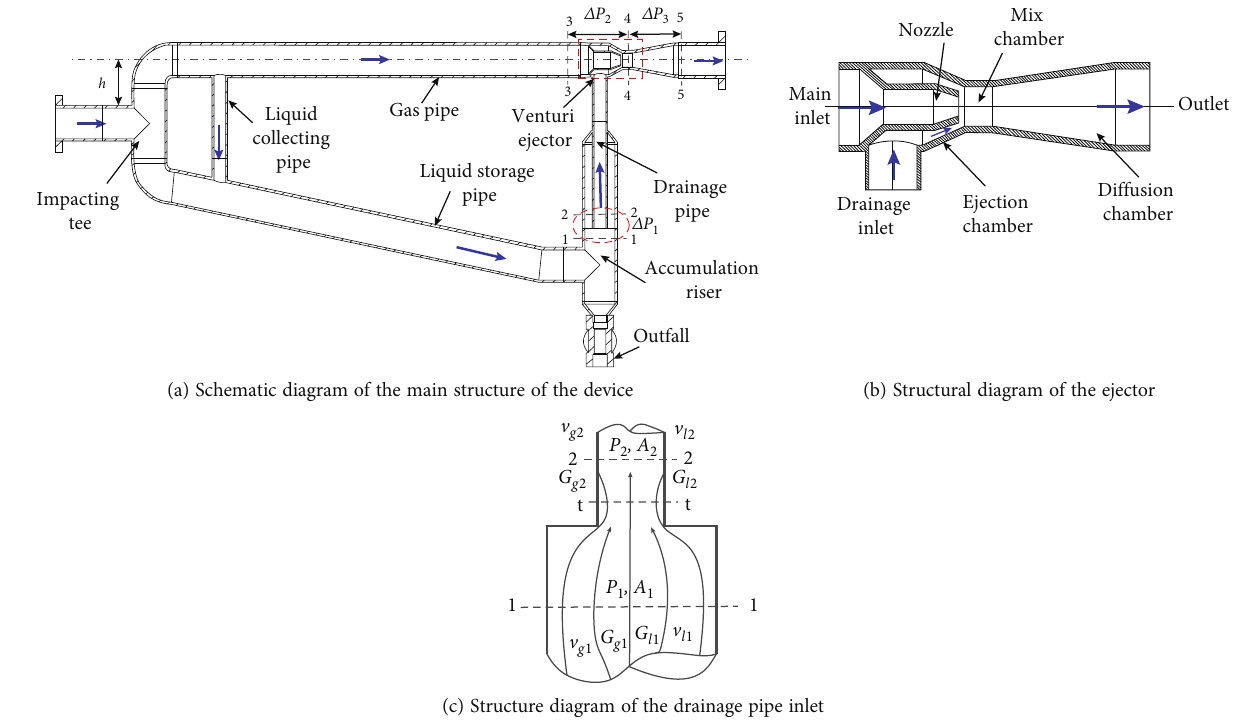
Figure 2: Schematic design of the main structure of the slug fl ow elimination device (the blue arrow is the fl ow